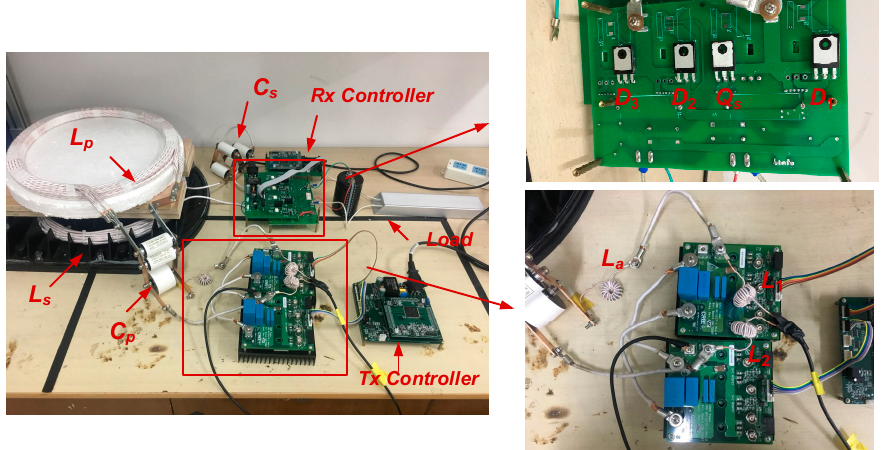
Figure 14. Prototype of the proposed system.